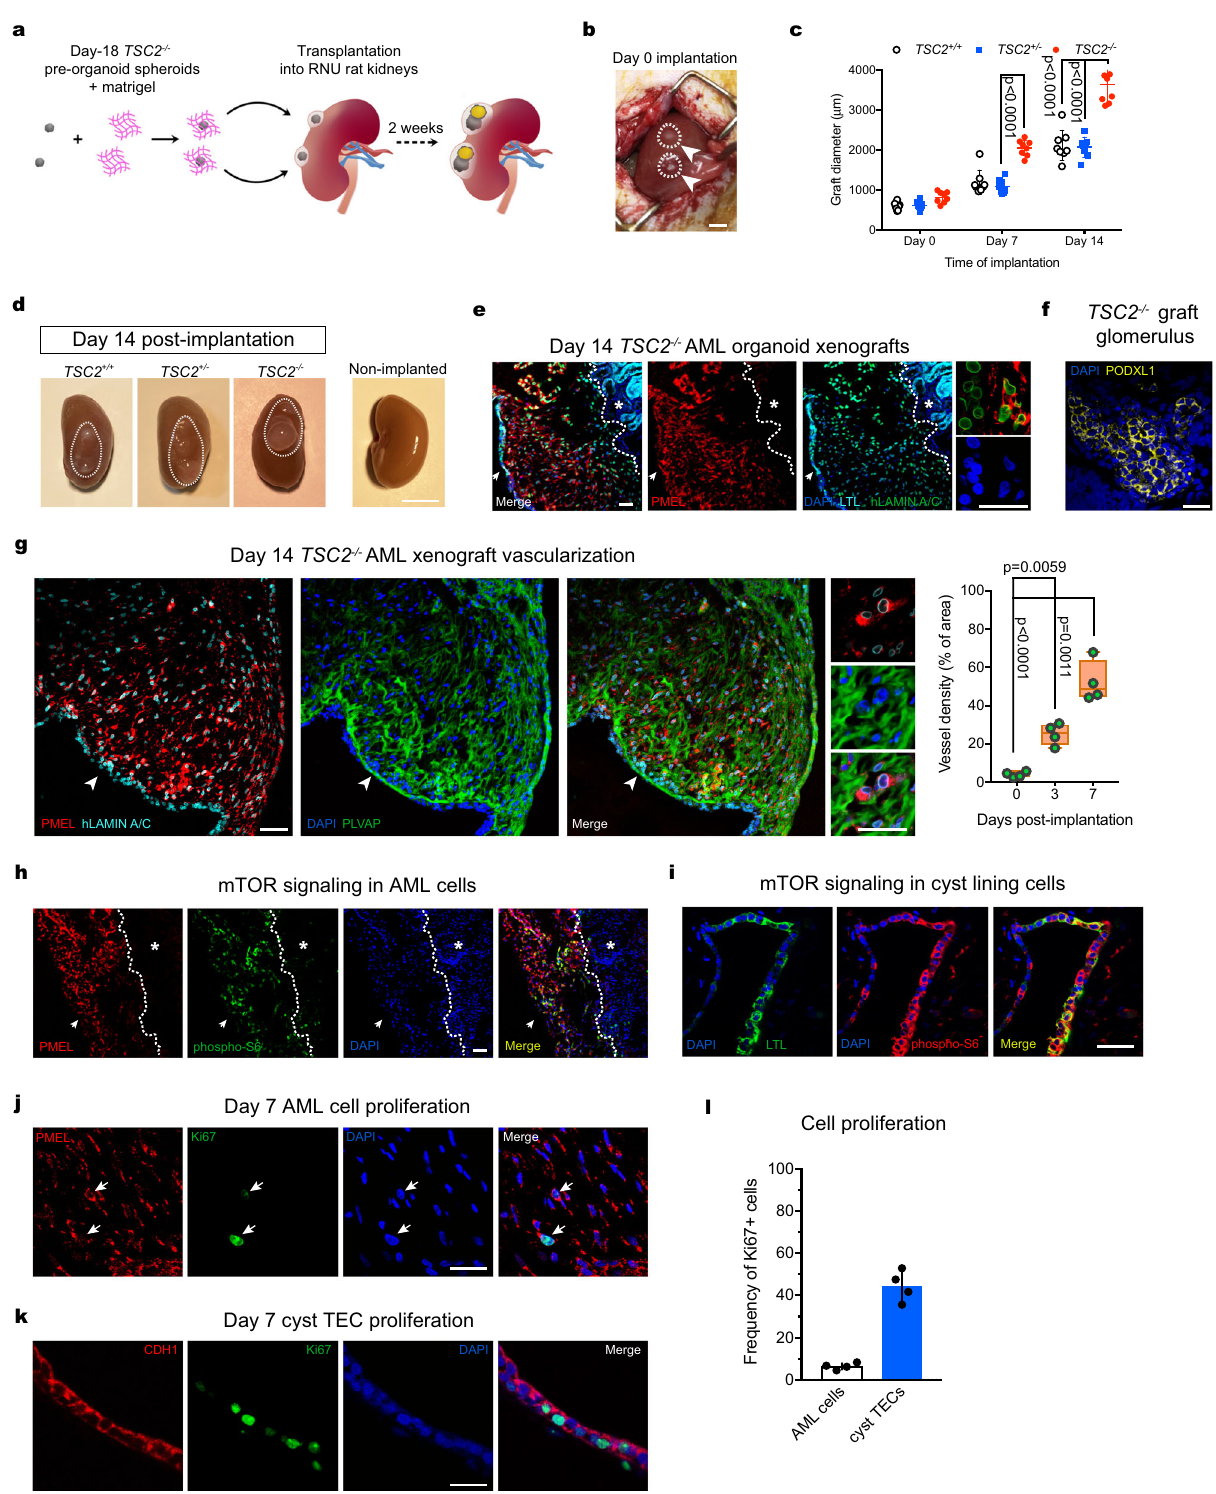
were also preserved in the transplanted organoids. Of note, both the ACTA2 + and PMEL + cells were observed in close proximity to microvascular endothelium of host origin that was visualized through detection of the marker plasmalemma vesicle-associated protein (PLVAP) (Fig. 5g), which is expressed by the micro- vasculature of the kidney 37 . In addition, mTOR activation, assessed by pS6 expression, was observed in both ACTA2 + or PMEL + cells of TSC2 − / − AML organoid graft cells, but not in